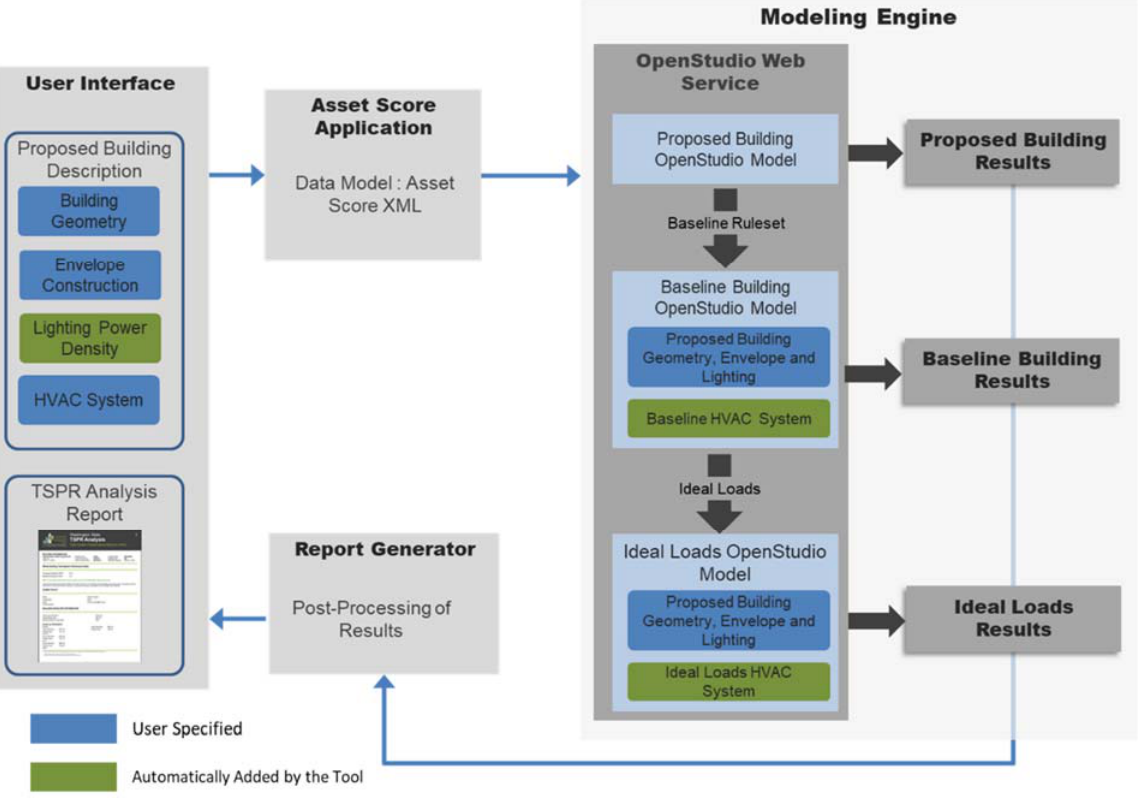
Figure 2. HVAC System Performance tool structure for HVAC System Performance analysis.